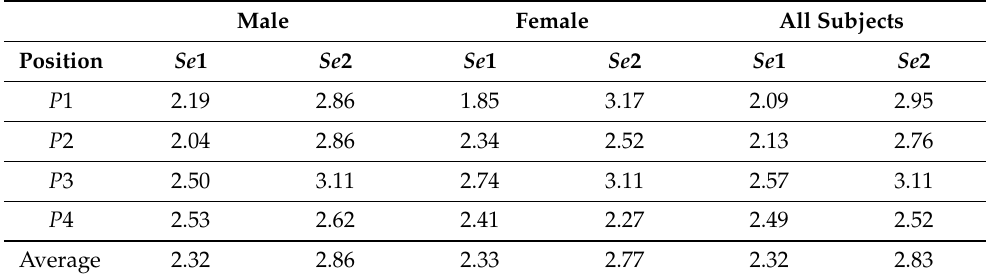
Table 1. The respiration estimation shows the agreement on carrying less error by Se 1 under the thoracic region compared to Se 2 under the abdominal region for both genders and in all positions. Male Female All Subjects